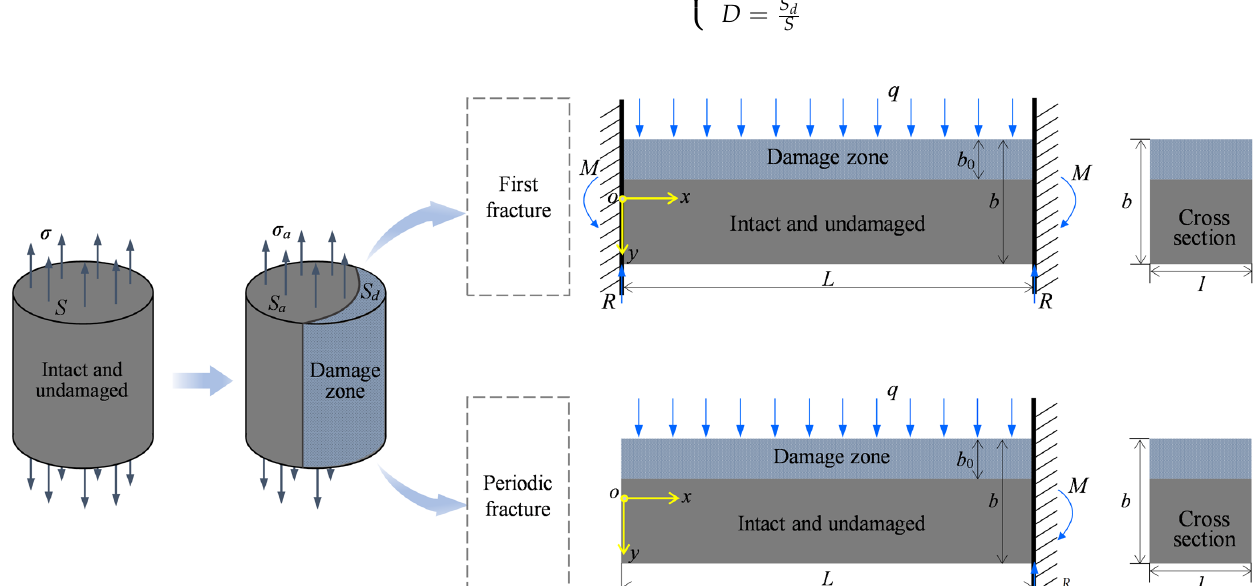
Figure 4. Mechanics model of first and periodic fracture of the damaged main roof.